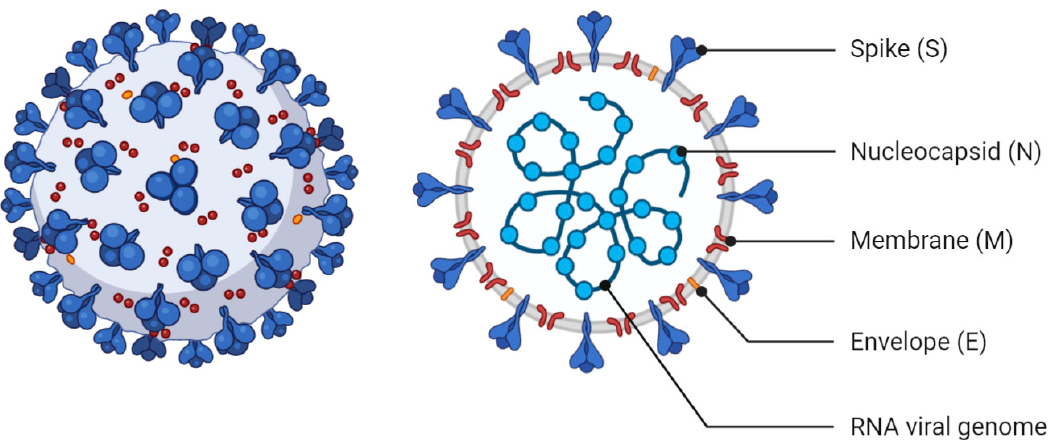
Figure 1. Schematic representation of the structure of SARS-CoV-2. It has at least four canonical structural proteins; E (envelope), M (membrane), N (nucleocapsid) and S (spike) proteins (Created with BioRender.com).